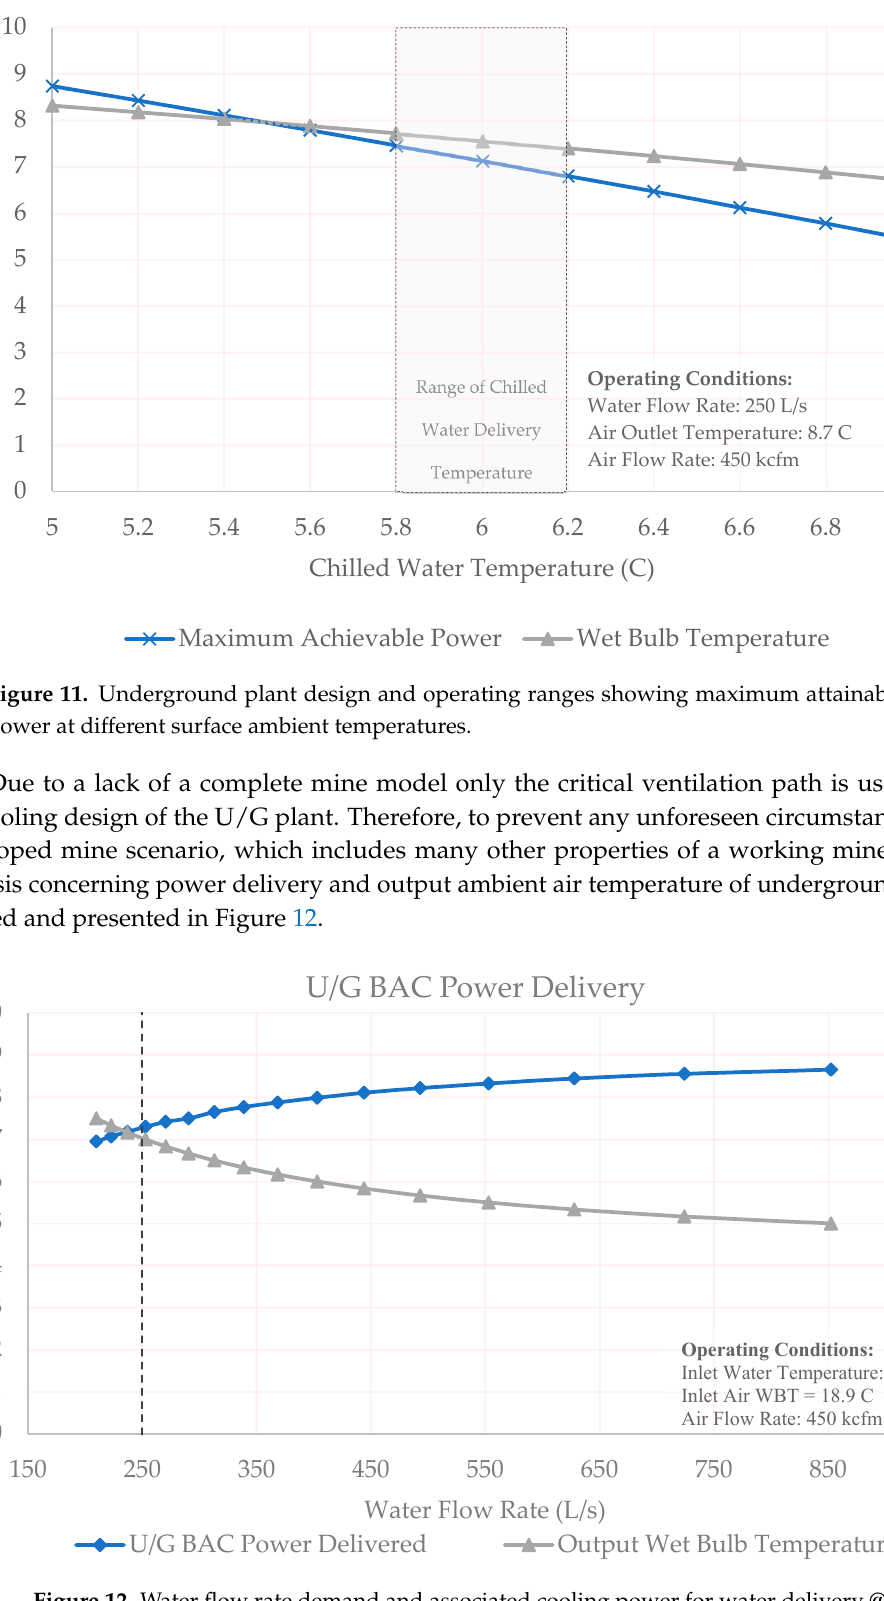
Figure 12. Water flow rate demand and associated cooling power for water delivery @ 6 °C.